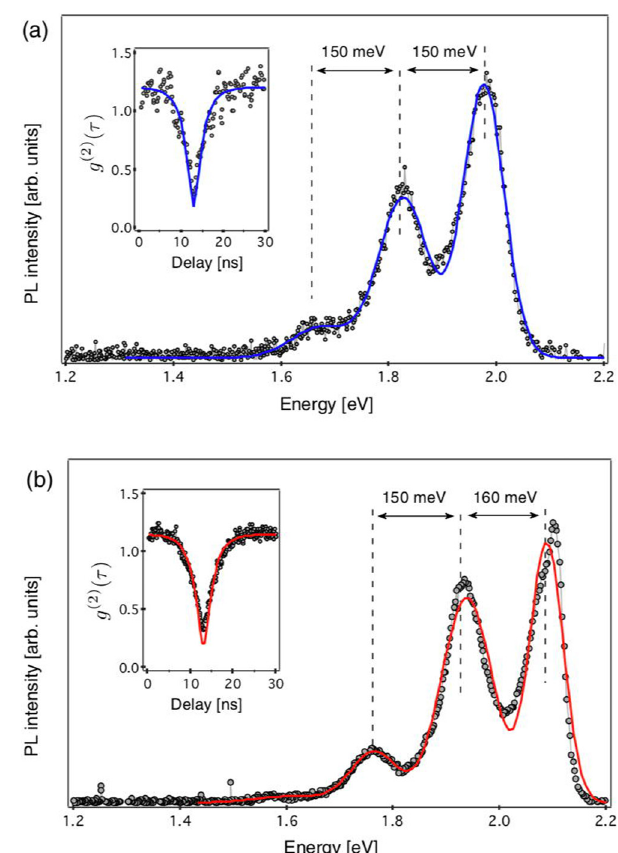
Figure17: (a),(b)PLspectrarecordedfromindividualdefectsat2eV inhBNatroomtemperatureundergreenlaserillumination.Thesolid lines are data fi tting with Gaussian functions. The insets show the corresponding second-order correlation function g (2) ( τ ). After refer- ence [58].